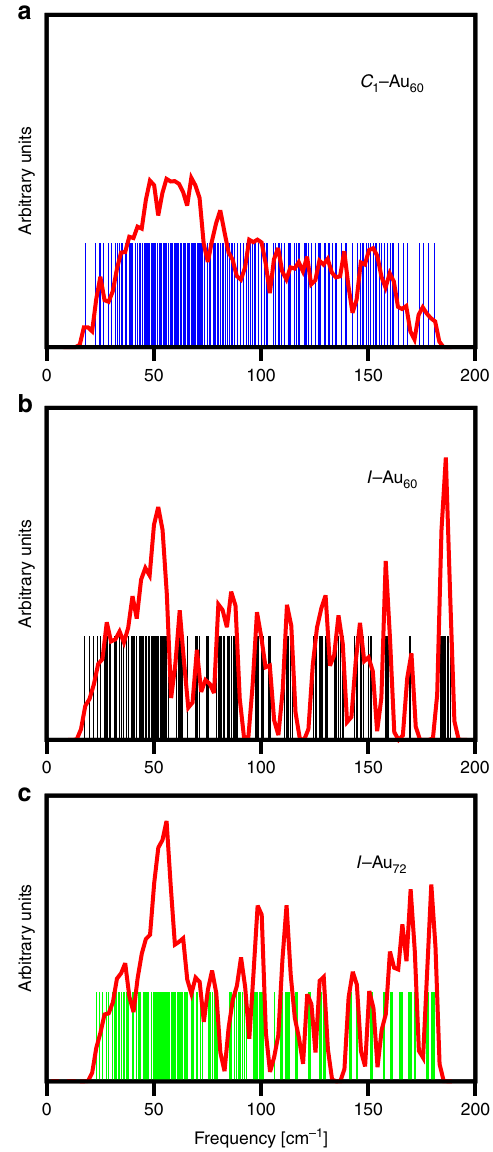
Fig. 5 Comparison of the spectrum of vibrational frequencies, or density